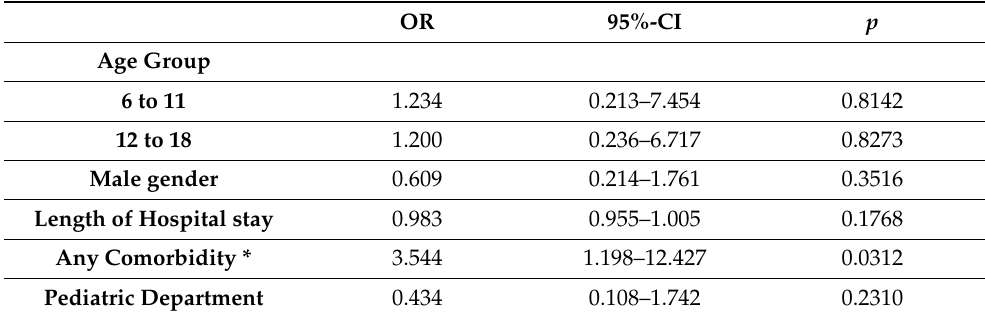
Table 6. Estimated odds ratio for patients treated at UM vs. non-UM (subgroup with OPS 5-340.0 or 8-144, drainage of the pleural cavity).